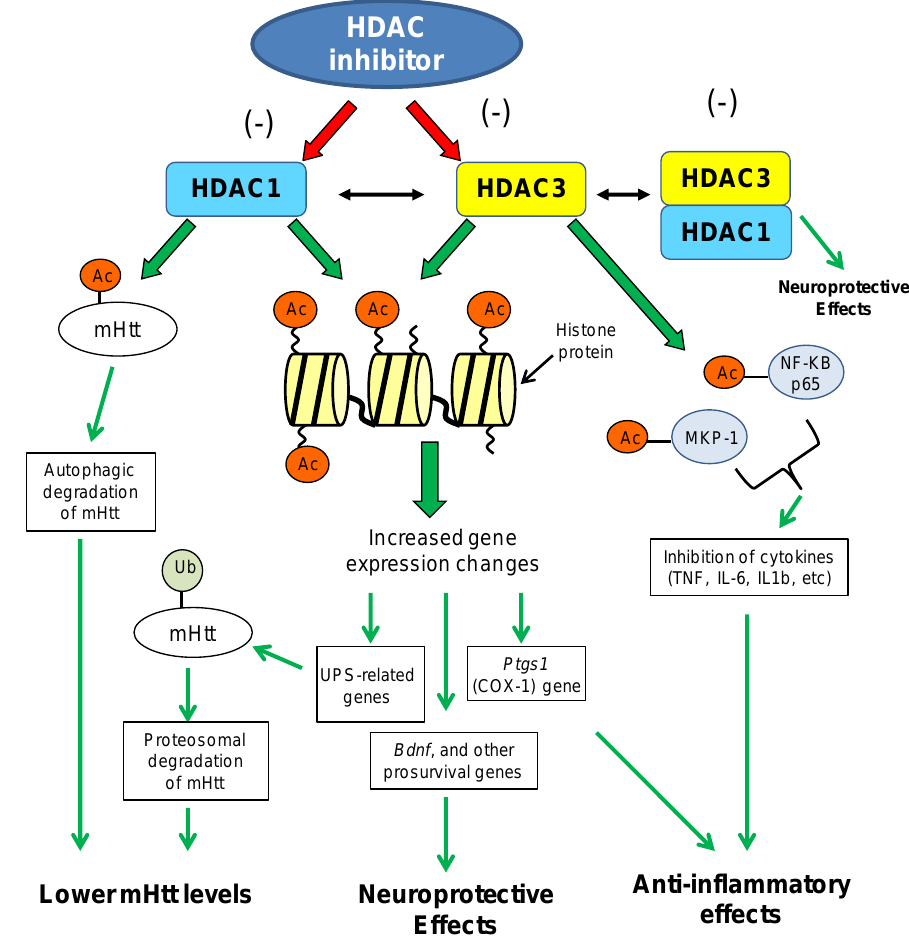
Figure 2. Potential chromatin- and non-chromatin-related mechanisms of HDAC1/HDAC3-targeting inhibitors in the context of Huntington’s disease. Different mechanisms associated with inhibition of HDAC1 and HDAC3 enzymes can lead to lowered mutant huntingtin (mHtt) levels, neuroprotective effects or anti-inflammatory effects, all of which can contribute to the improved disease phenotypes observed in HD model systems (see text for details). Neuroprotection by HDAC inhibitors could also be mediated through the inhibition of the HDAC1–HDAC3 interaction and subsequent toxicity of this interaction (see Ref 63). Acetyl group (Ac); Mutant huntingtin (mHtt); ubiquitin proteasomal system (UPS); brain-derived neurotrophic factor (Bdnf); prostaglandin-endoperoxide synthase 1 (Ptgs1/COX1); mitogen-activated protein kinase phosphatase-1 (MKP-1); nuclear factor kappa-light-chain-enhancer of activated B cells